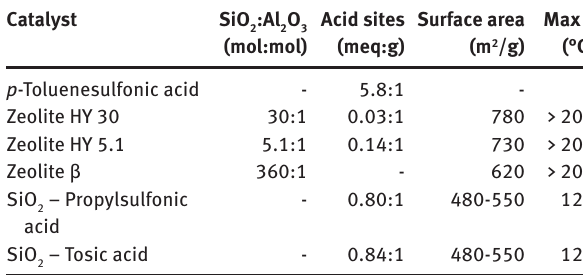
Table 2: Characteristics of acidic